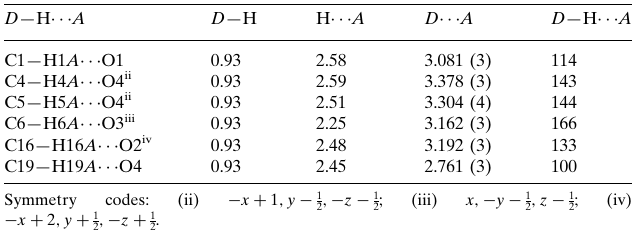
Hydrogen-bond geometry (A˚ , (cid:2)